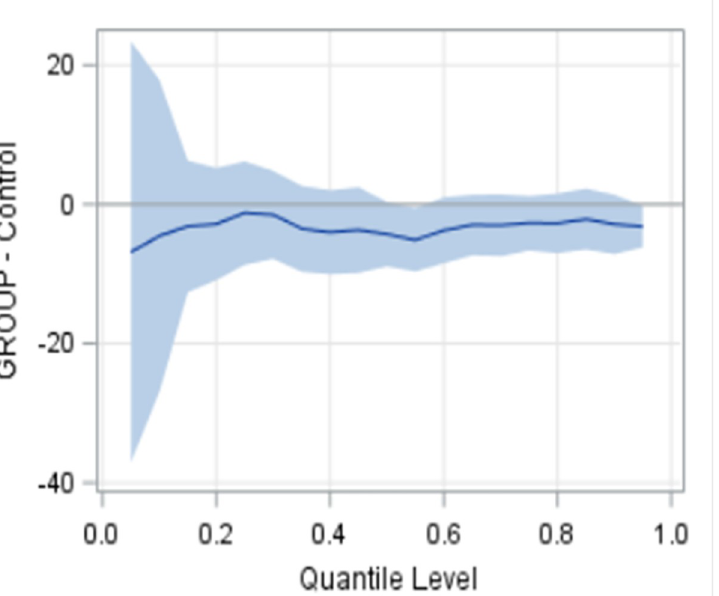
Fig 3. Quantile regression results: Baseline to six-month change in